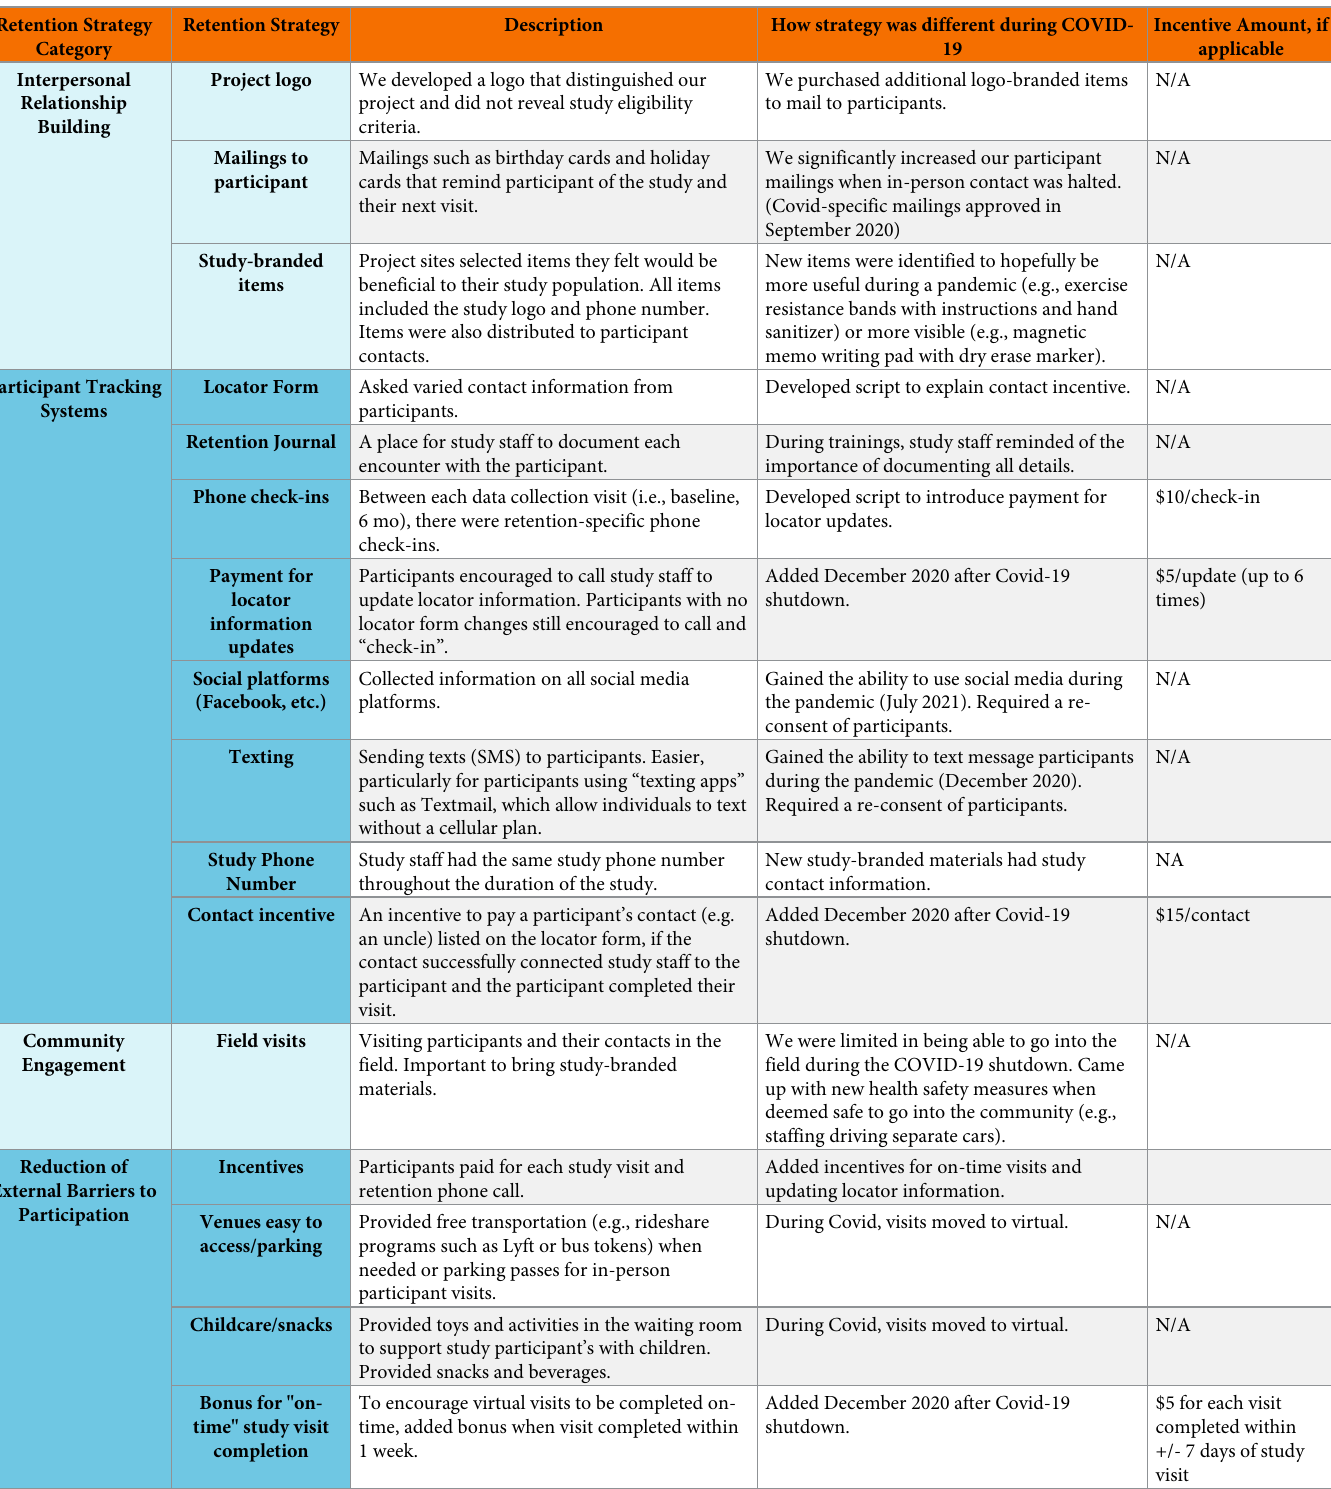
Table 2. Retention strategies and changes during COVID-19 for STUDY PARTICIPANTS